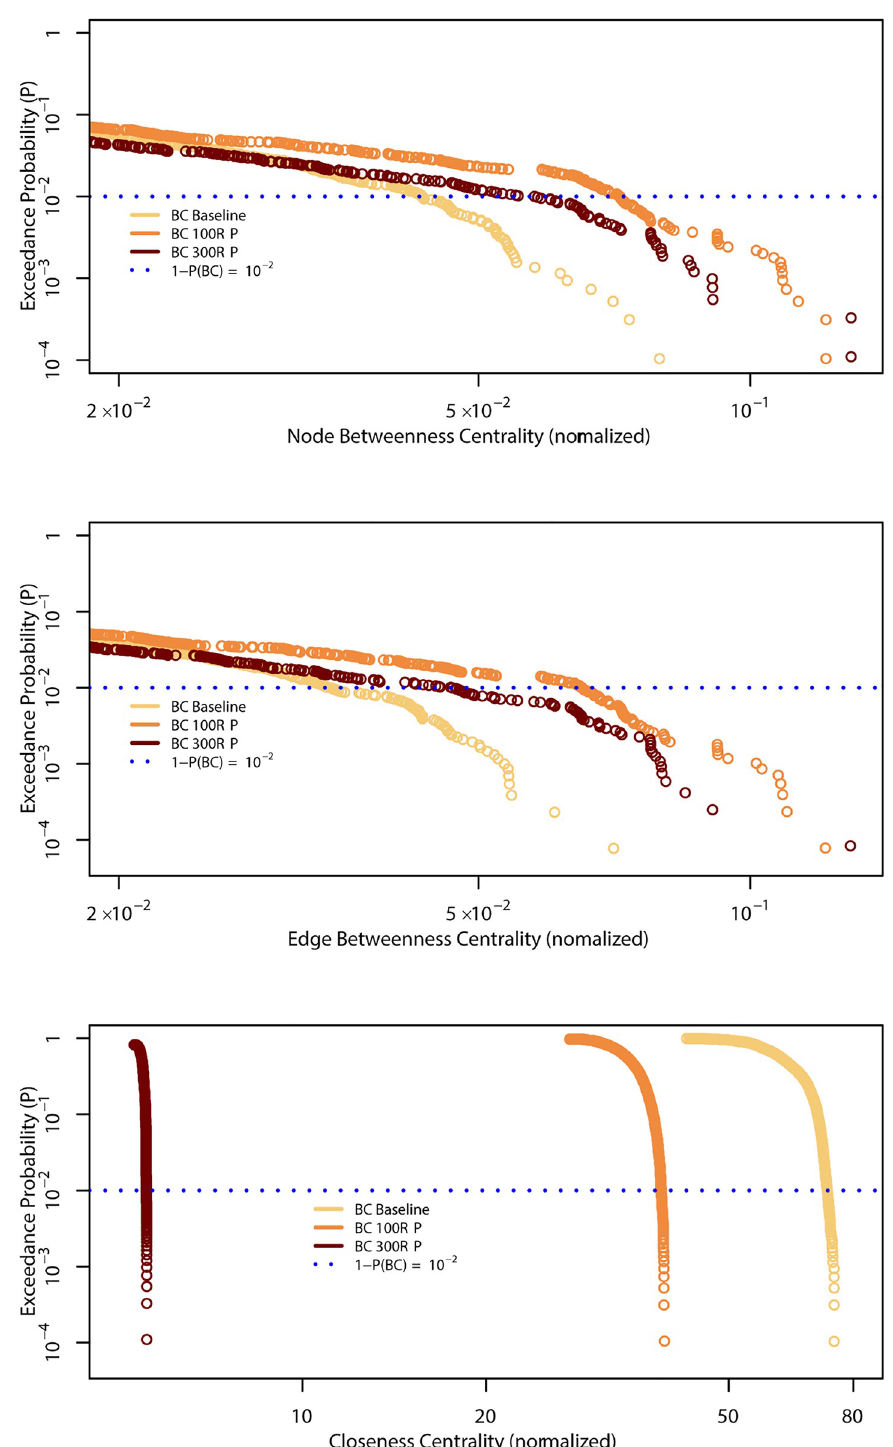
Fig 1. Complementary distribution functions for baseline conditions and 2 flooding scenarios, based on main roads at least 3 m wide. Edge and node betweenness centralities were calculated using average road widths as network